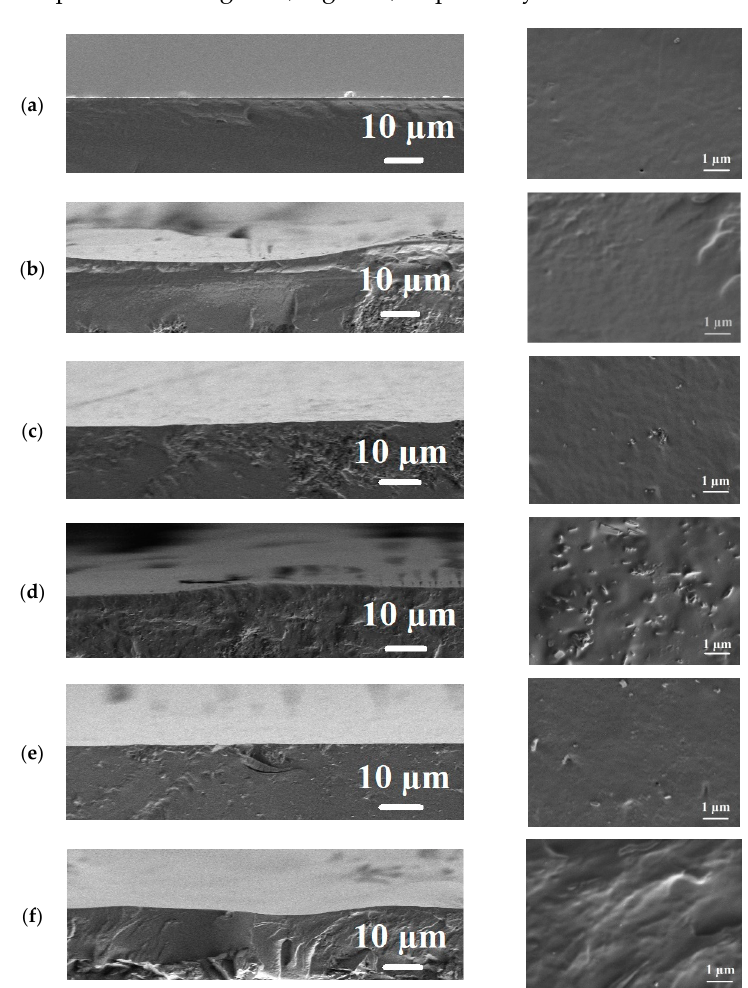
Figure 5. The cross-sectional SEM micrographs at different magnification for the uncross-linked PVA and PVA/Zr-MOFs membranes: ( a ) PVA; ( b ) PVA+MIL-140A(5%); ( c ) PVA+MIL-140A(10%); ( d ) PVA+MIL-140A(15%); ( e ) PVA+MIL-140A-AcOH(10%); and ( f ) PVA+MIL-140A-AcOH-EDTA(10%). The presented SEM micrographs demonstrate that the uncross-linked PVA mem- brane had a rather smooth and uniform cross-sectional structure (Figure 5a). The intro- duction of 5 wt% MIL-140A (Figure 5b) slightly increased the roughness of the cross-sec- tion. The introduction of 10 and 15 wt% MIL-140A (Figure 5c,d) into the PVA matrix vis- ualize MOF particles on the membrane cross-sections, the number of which increases with the rise of MIL-140A content. The introduction of 10 wt% MIL-140A-AcOH (Figure 5e) and MIL-140A-AcOH-EDTA (Figure 5f) into the PVA matrix also altered the cross-sec- tional structure of the membranes. These included: the appearance of plastic defor- mations, which are cross-sectional irregularities caused by immersion membrane in liquid nitrogen with subsequent cleavage and enhanced by embedded particles, and the visibil-